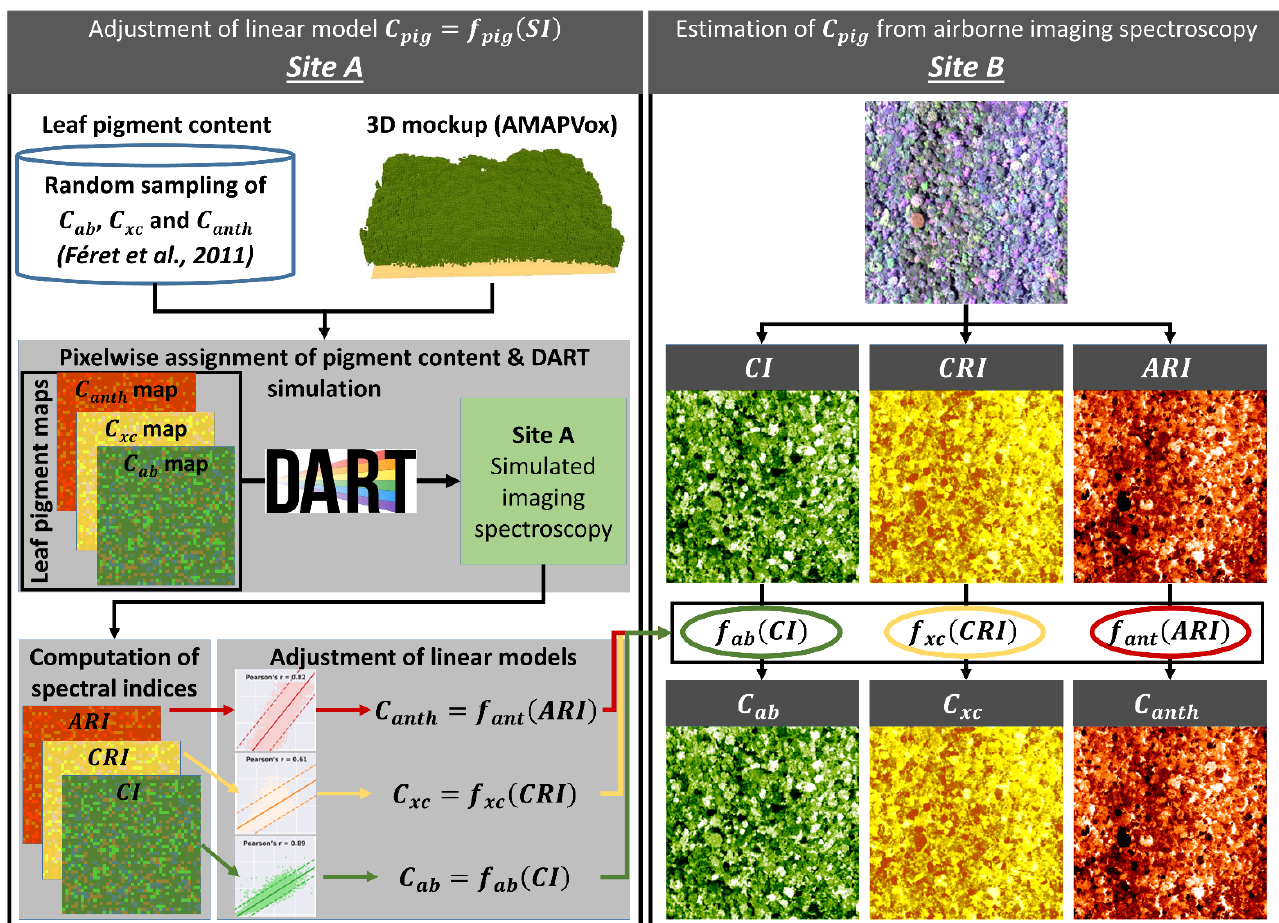
Figure 3. Procedure followed to assign leaf pigment content to simulations. The panel on the left side describes the adjustment of the linear models linking pigment content ( C pig ) to its corresponding spectral index ( SI ) based on DART (Discrete Anisotropic Radiative Transfer) simulations from site A. The panel on the right side describes the computation of pigment content from airborne imaging spectroscopy acquired over site B, based on the linear models adjusted on site A.